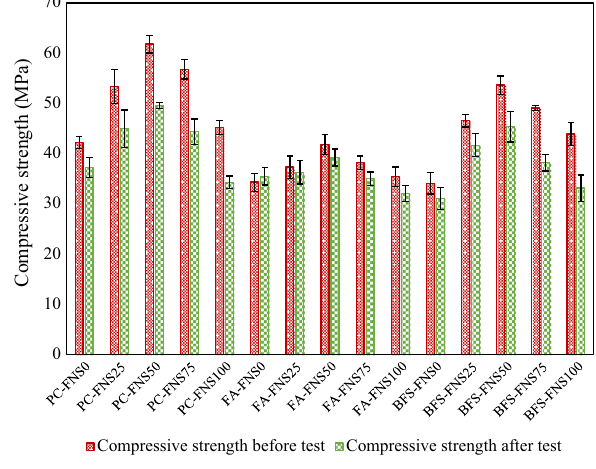
Fig. 7 Compressive strength comparison before and after wet–dry cycles (error bars are at one standard deviation).